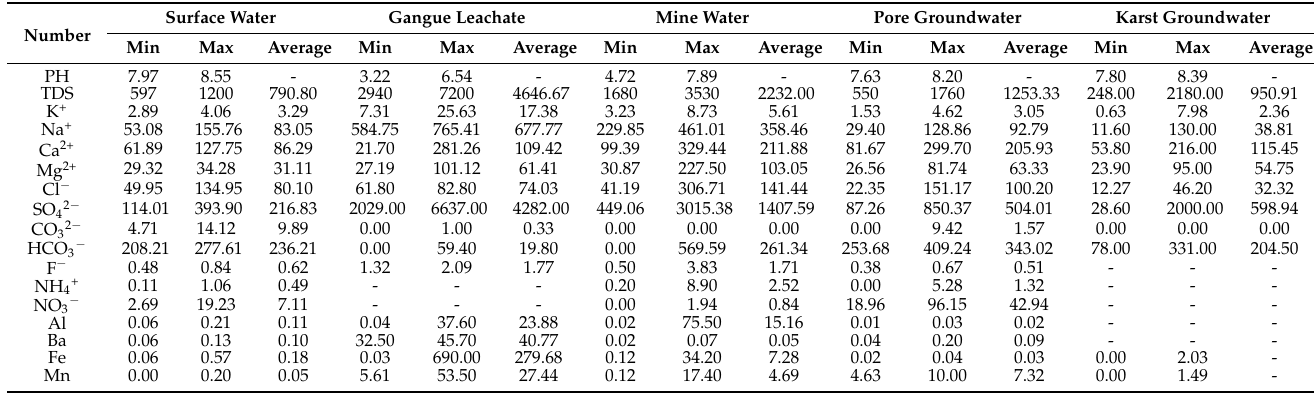
Table 1. Statistics of physicochemical parameters of different group